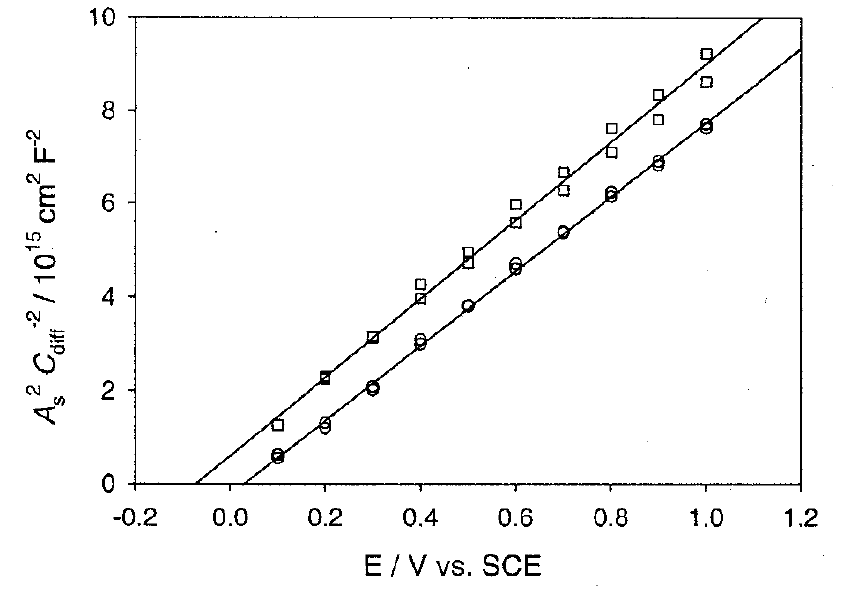
Figure 7. Mott-Schottky plots for n-type ZnO in contact with phthalate buffer solutions at pH 4 (circles) and pH 6 (squares) (adopted from Ref.